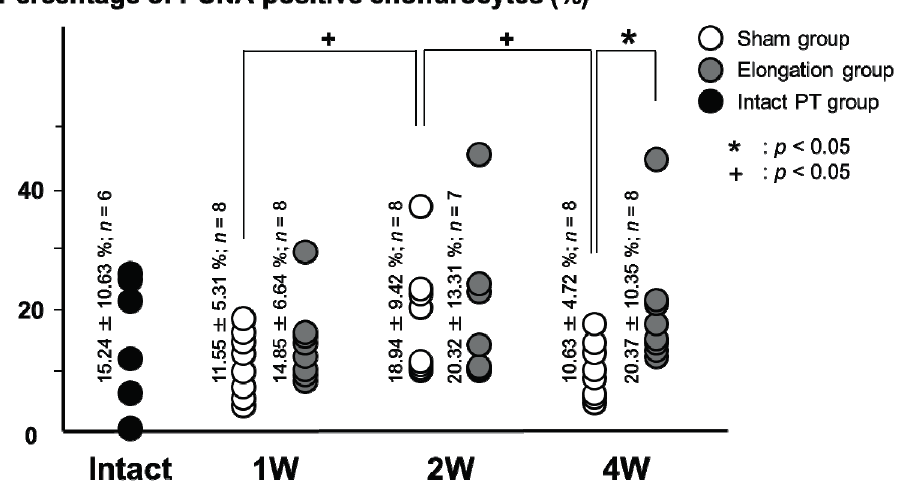
Figure 3. Proportion of PCNA-positive cells. The average percentages of PCNA-positive chondrocytes in the elongation group was significantly higher than that in the sham group at 4 weeks ( p = 0.018). In sham group, the average percentages of PCNA-positive chondrocytes at 2 weeks is higher than those at 1 week ( p = 0.037) and 4 weeks ( p =